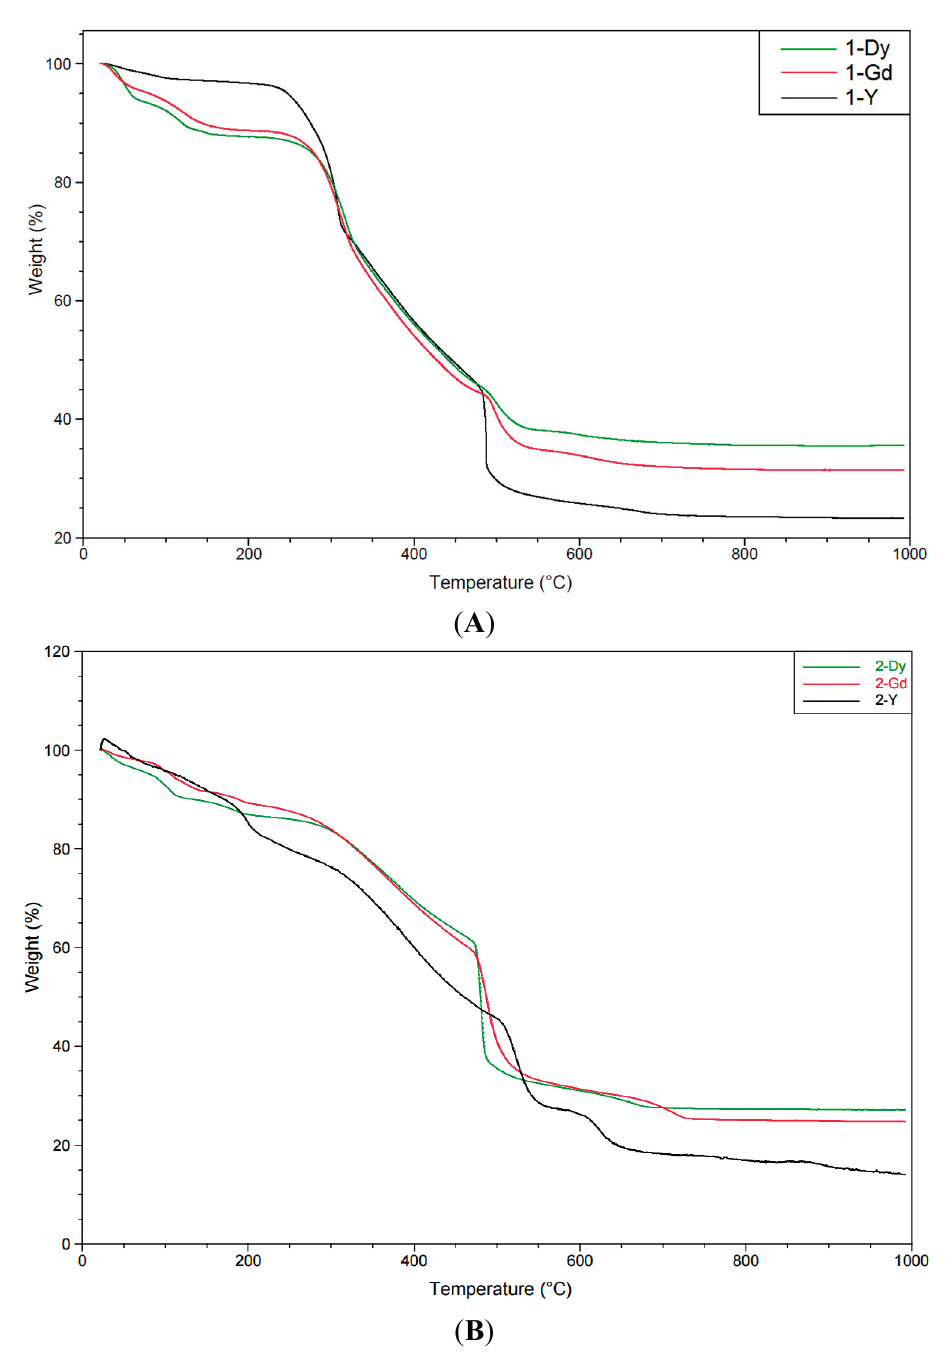
(Figure S7). In order to examine the thermal stability of all complexes, TGA was carried out between room temperature and 1000 °C under N 2 atmosphere. The TGA curves are presented in Figure 4.